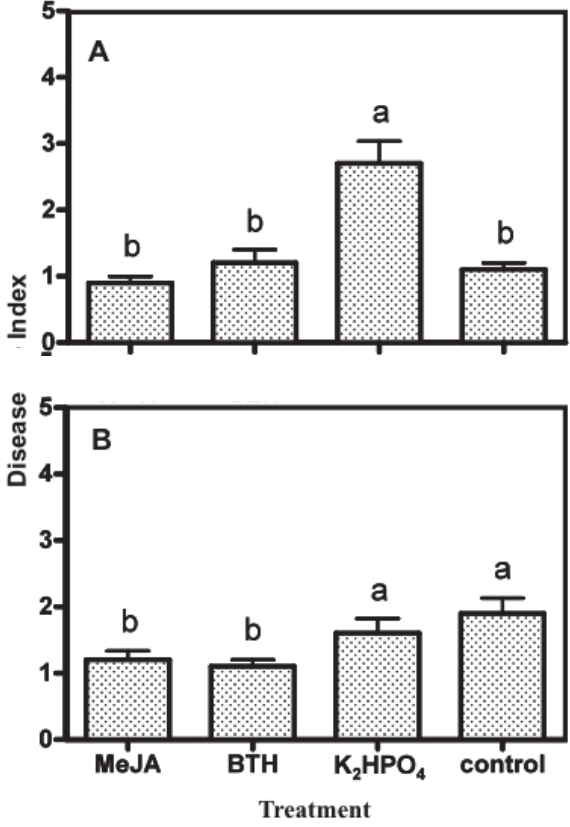
Figure 4. Effect of soaking melon seeds in methyl jas- monate (MeJA), acybenzolar-S-methyl (BTH) and di- potassium hydrogenphosphate (K HPO ) followed by 2 4 foliar sprays, in reducing the disease index of melon plants grown in soil naturally infected with Monospo- rascus cannonballus in 2006 (A) and 2007 (B). data are the means ± Sd. data followed by the same letters are not significantly different at P ≤0.05 (Dunn test